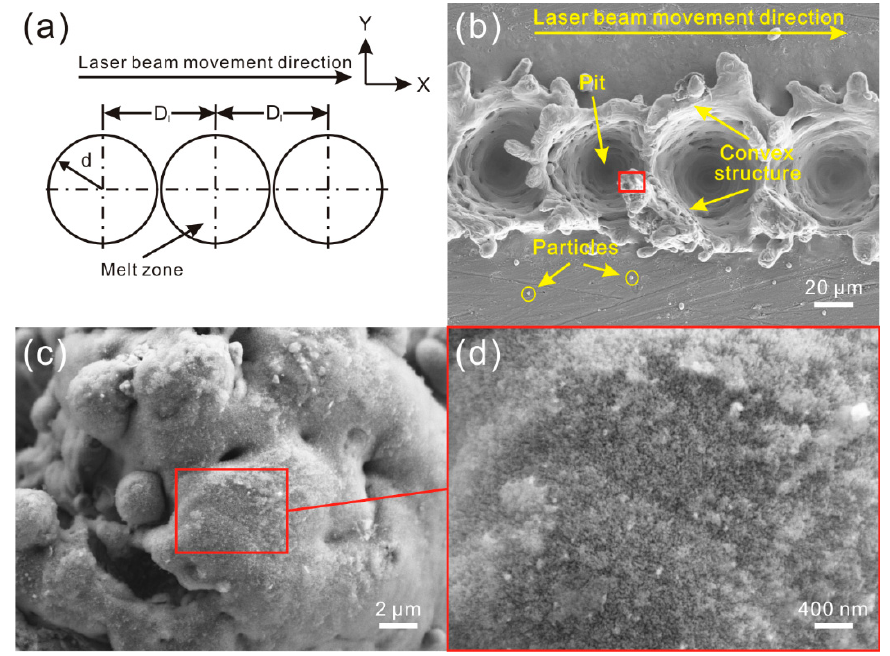
Figure 3. ( a ) Schematic of overlap degree of molten pools (no overlap of melting zone, i.e., D 1 ≥ 2d); ( b ) SEM image of the microstructure on Al alloy surface (laser beam pulse frequency of 10,000 Hz, laser beam scanning speed of 0.4 m/s); ( c , d ) high-magnification SEM image of the microstructure.